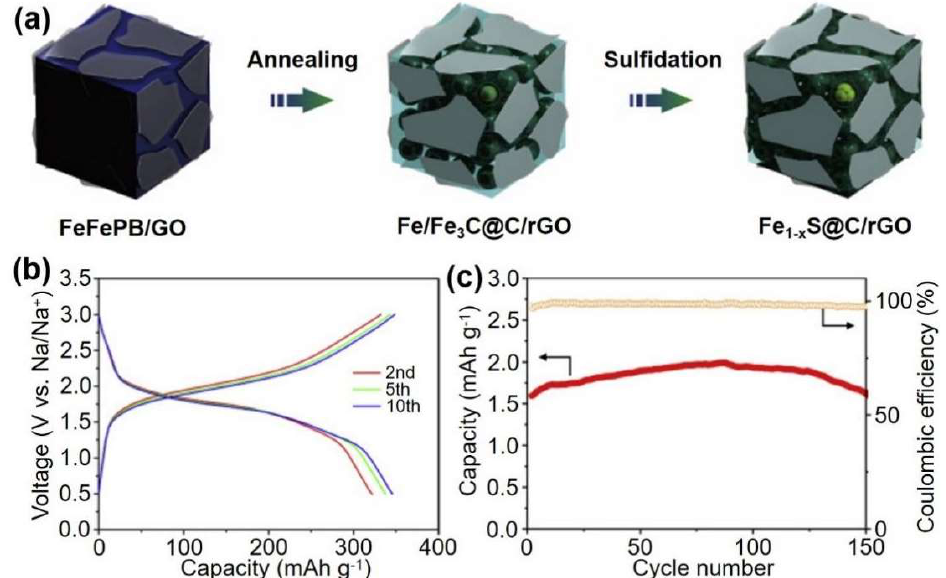
Figure 4. ( a ) Illustration of the formation process of Fe 1−x S@C/rGO. ( b ) Galvanostatic dis- charge/charge curves of sodium ion full cells at different cycles at a current density of 200 mA g −1 . ( c ) Cycle performance of sodium ion full cells at a current density of 200 mA g −1 (capacities are calculated based on anode mass). Ref. [17] Copyright Electrochimica Acta, Elsevier.